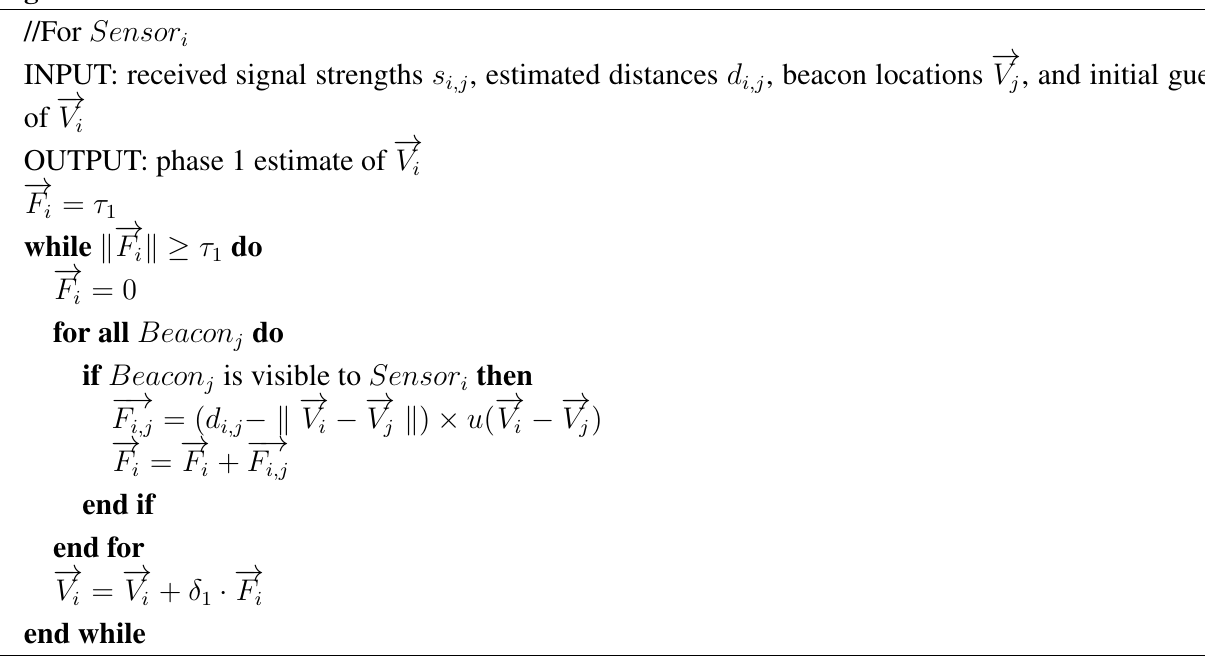
Algorithm 1 Coarse Location